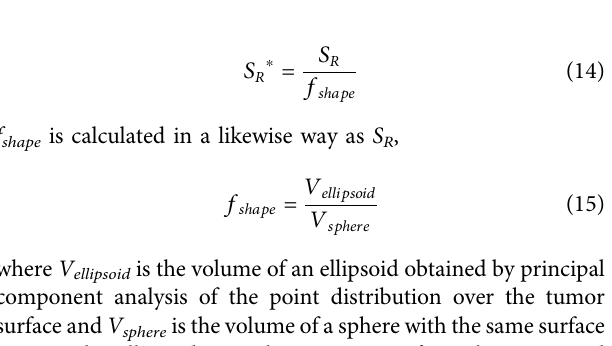
FIGURE 4 | Analysis of angular ordered series (A) Connectivity series. (B) local standard deviation of the connectivity series showing a power-law dependence on ϕ .